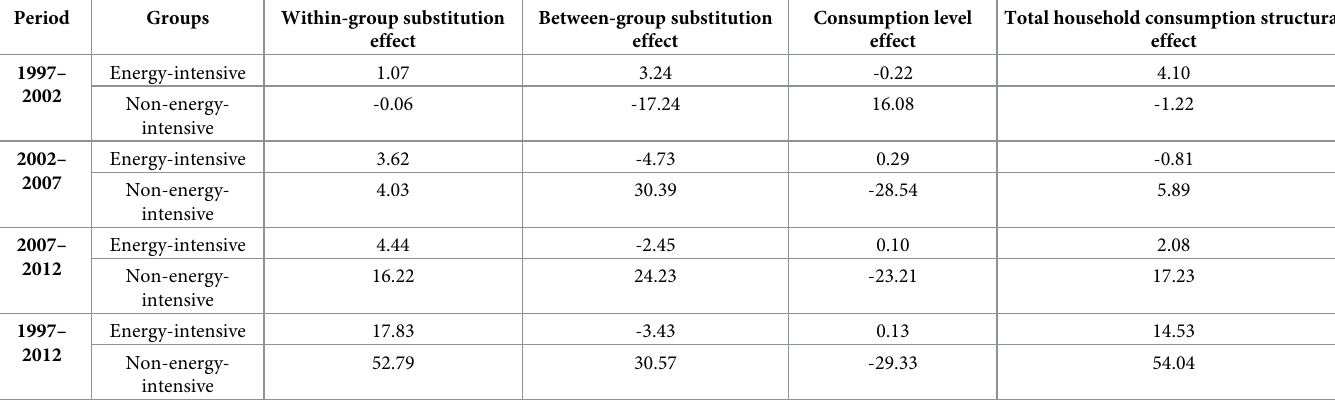
Table 3. Attribution of consumption substitution effects to household indirect consumption changes between 1997 and 2012 (Unit: Mtce). Period